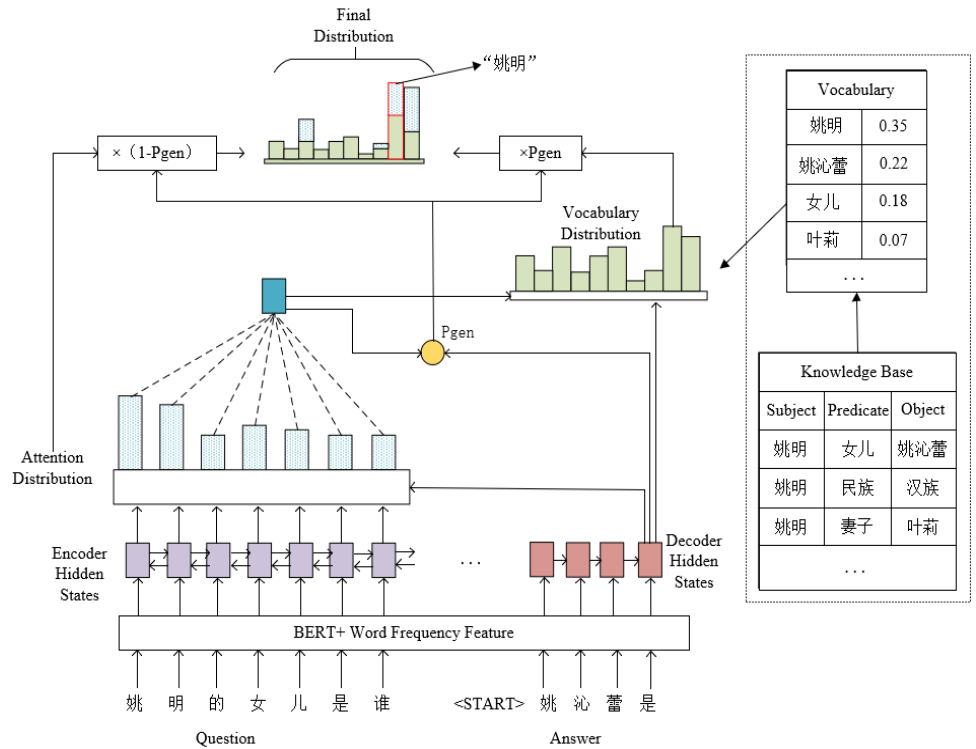
Figure 3. Answer generation model structure diagram. “ 姚明的女儿是谁 ” (in Chinese): Who is Yao Ming’s daughter?; “ 姚沁蕾是 ” (in Chinese): Yao Qinlei (Yao Ming’s daughter) is; “ 叶莉 ” (in Chinese): Ye Li (Yao Ming’s wife); “ 汉族 ” (in Chinese): Han nationality.